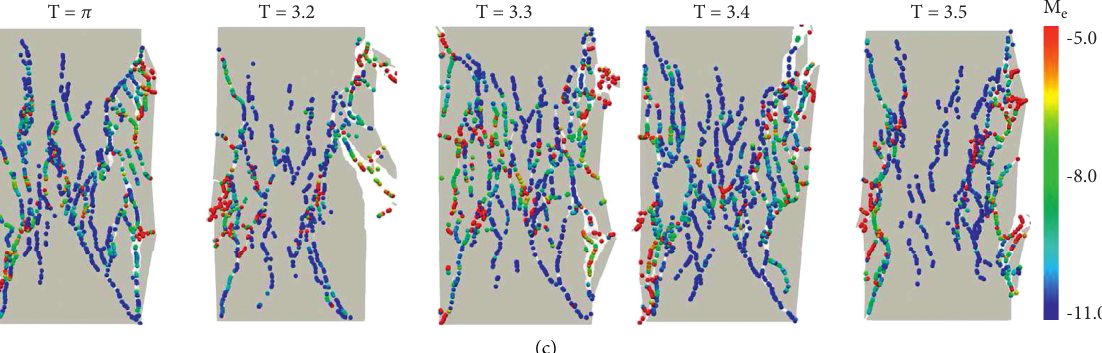
Figure 9: (a) Failure phenomenon under different elliptic coefficients of amygdale conditions (green � tensile crack and red � shear crack, respectively); (b) the AE evolution; (c) the AE events’ energy, M e , measured based on the kinetic energy of the AE sources.